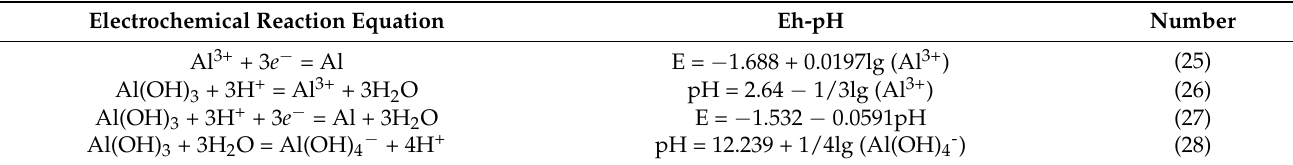
Table 2. Main electrochemical reaction equations of Al-H 2 O system. Electrochemical Reaction